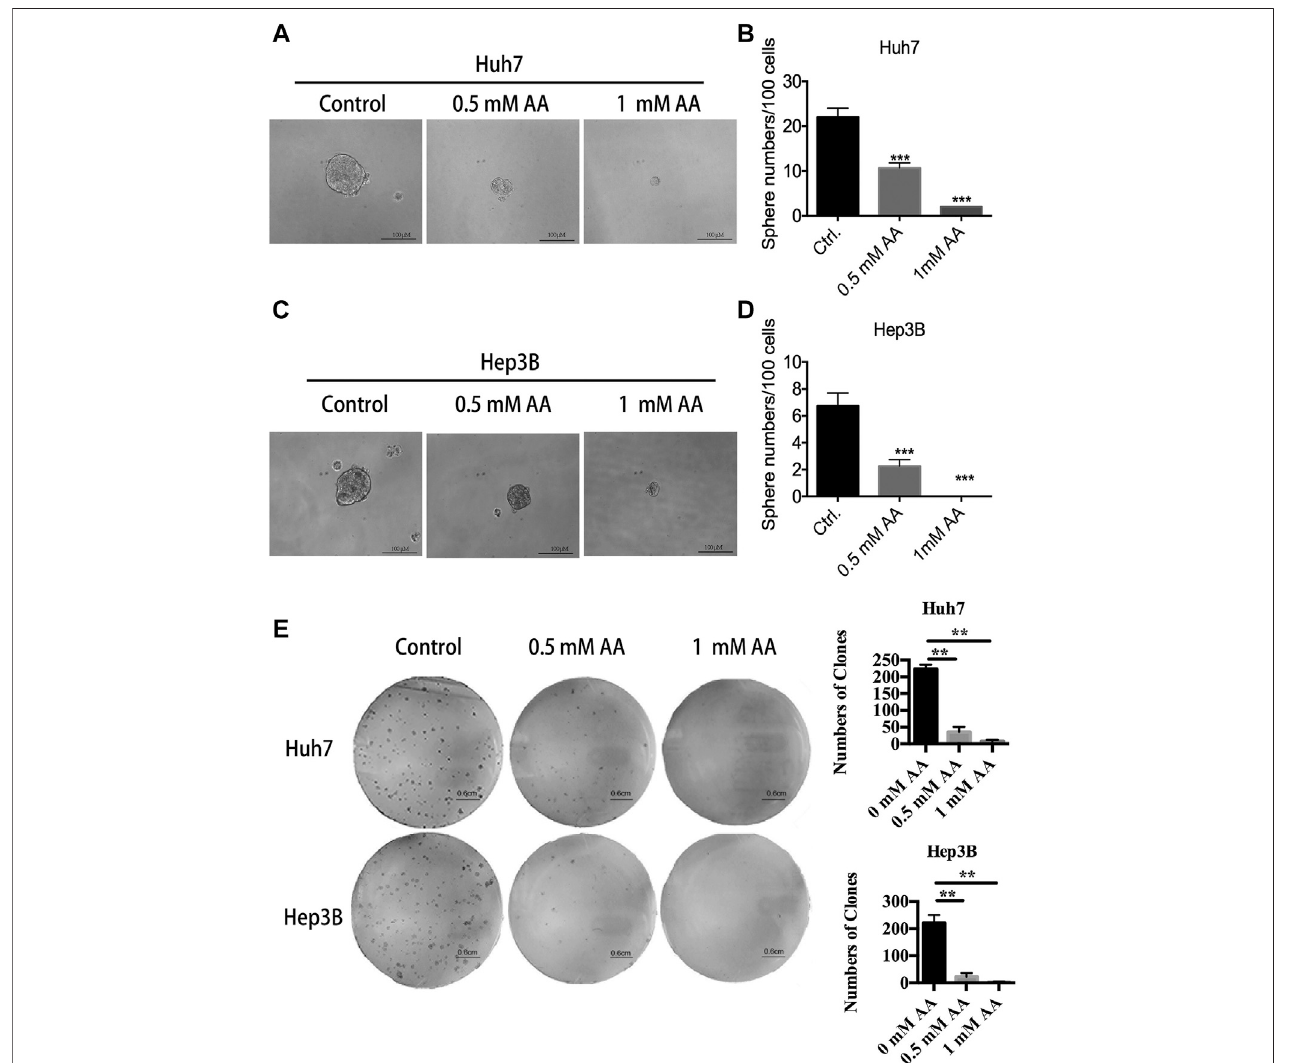
FIGURE2| AAreducessphereformationandcolonyformationbylivercancercells. (A) ImageofspheresformedbyHuh7cellsaftertreatmentwithAAatindicated concentrations for 14 days. (B) Sphere numbers of Huh7 cells after treatment with AA at indicated concentrations for 14 days. (C) Image of spheres formed by Hep3B cells after treatment with AA at indicated concentrations for 14 days. (D) Sphere numbers formed by Hep3B cells after treatment with AA at indicated concentrations for 14 days. (E) Colonies formed by Huh7 or Hep3B cells after treatment with AA at indicated concentrations for 14 days. *** p < 0.001.